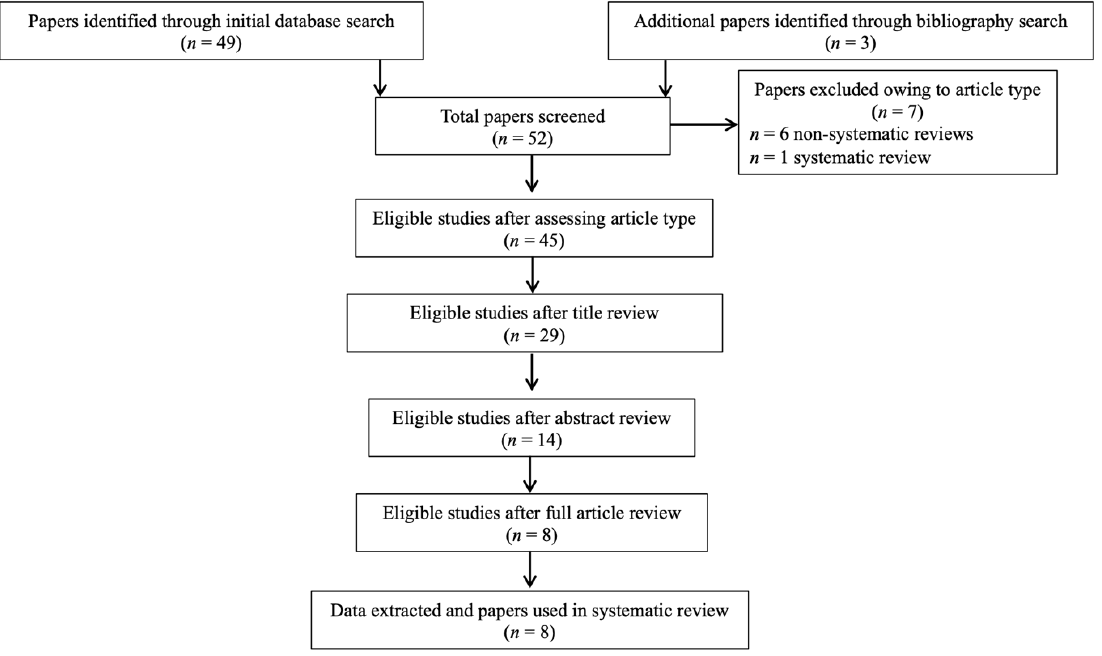
Figure 1. PRISMA flowchart of search strategy for systematic review.